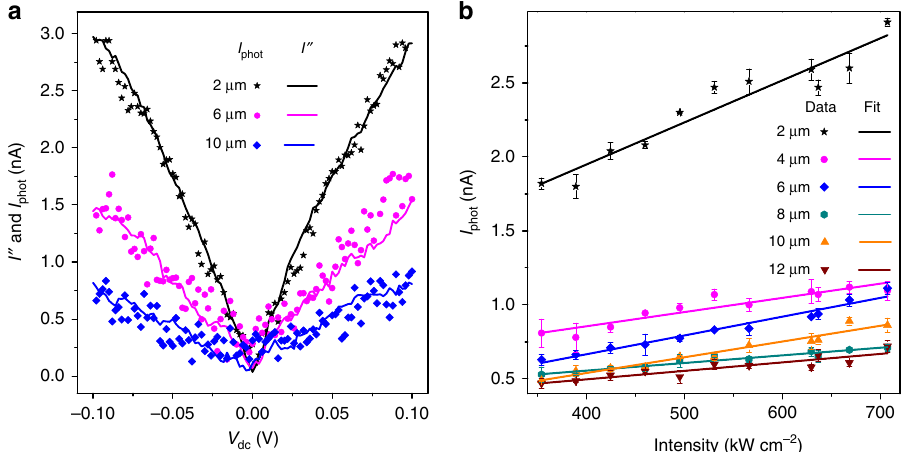
Fig. 5 Transduced current vs bias and excitation laser power. a Variation of I phot and I ” as a function of V dc for three distant optical antennas. b Plot of I phot as a function of excitation laser intensity for all the antennas. The data are recorded for V dc = 50